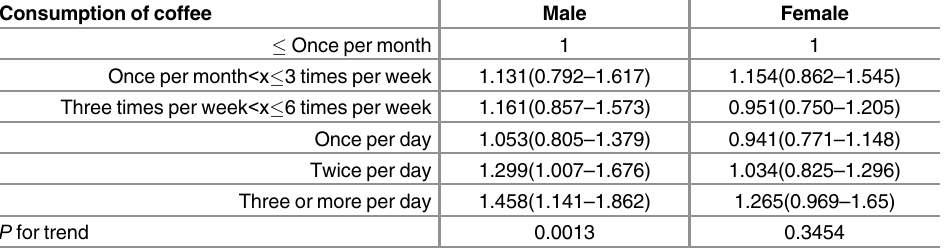
Table 3. Adjusted odds ratio, 95% confidence interval and P value of prevalence of periodontitis in multivariate logistic regression model for consumption of coffee. Consumption of coffee Male